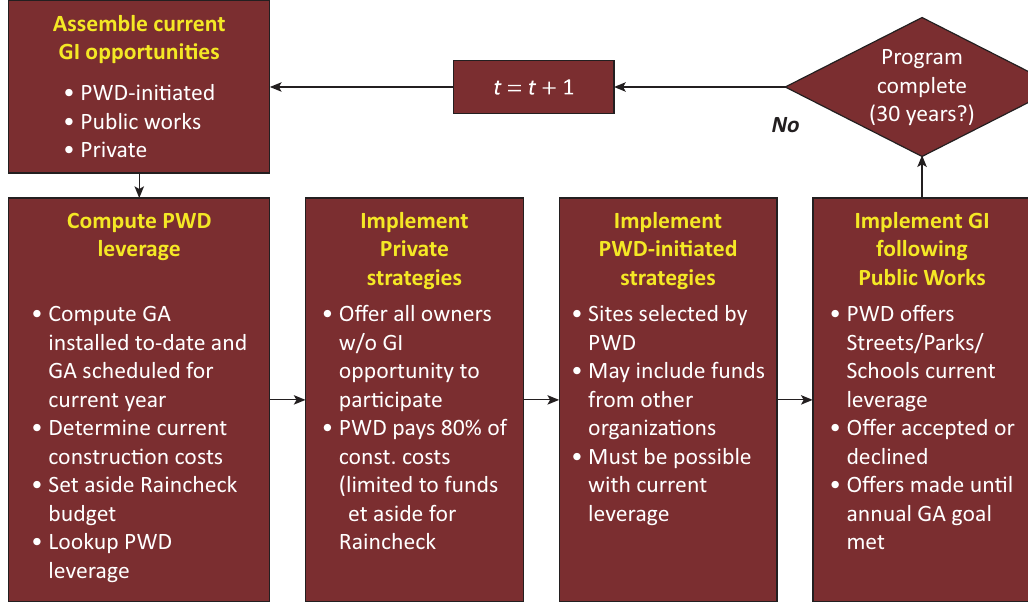
Point Breeze Greened